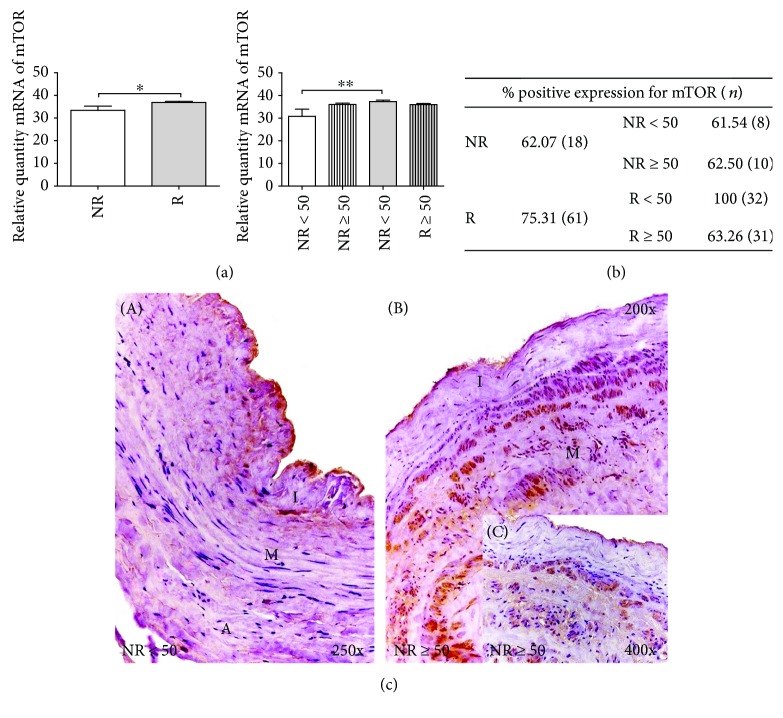
(a) Significant levels of mRNA for mTOR quantified by RT-qPCR in R and R < 50 patients. Results were normalized to that of the reference gene GAPDH and are provided in arbitrary units. NR = no reflux; R=reflux. ∗p < 0.05 and ∗∗p < 0.005. (b) Distribution of the percentage of patients with positive protein expression for mTOR in NR and R patients and by age; n = number of patients. (c) A: Histological images for protein expression mTOR in the different tunicae of venous wall in NR < 50 patients (350x). B, C: mTOR protein expression images in NR ≥ 50 patients (200x–400x). The brown coloration indicates the specific precipitate that correlates with the expression of the said protein. A = tunica adventitia; M = tunica media; I = tunica intima.